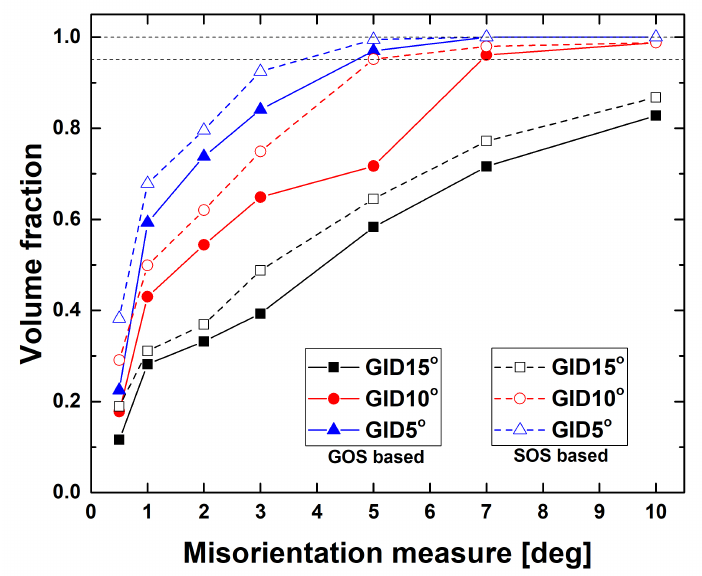
Figure 14. Misorientation measures of GOS and SOS obtained from initial microstructure of Mg-Al-Mn